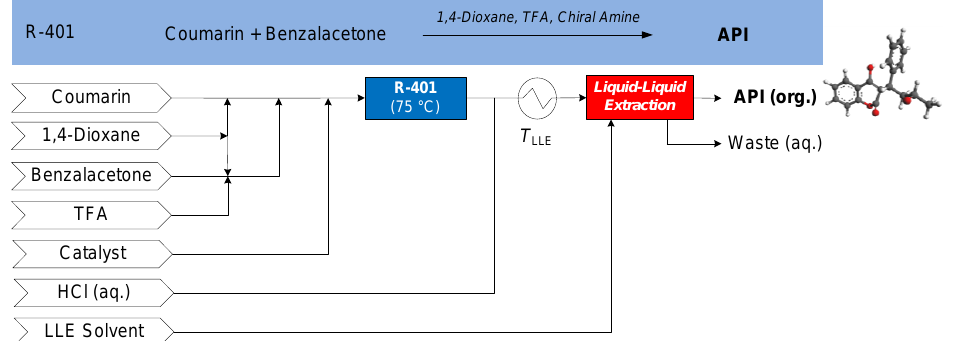
Figure 14. CPM flowsheet for warfarin: flow synthesis [67] + continuous LLE [68]. Reproduced with permission from Diab and Gerogiorgis, Computer Aided Chemical Engineering; published by